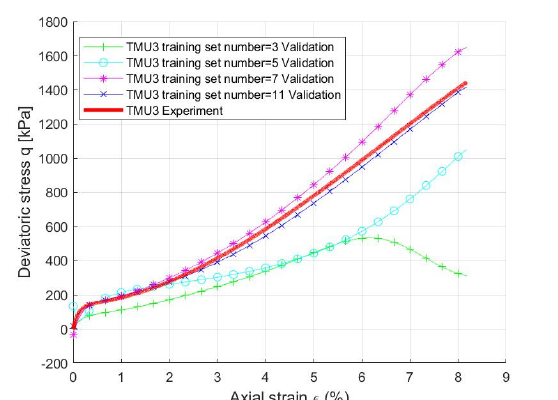
Fig. 4 Deviatoric stress q versus axial strain ε 1 in undrained monotonic triaxial tests ( I D0 = 0.62 and p 0 = 300 kPa).